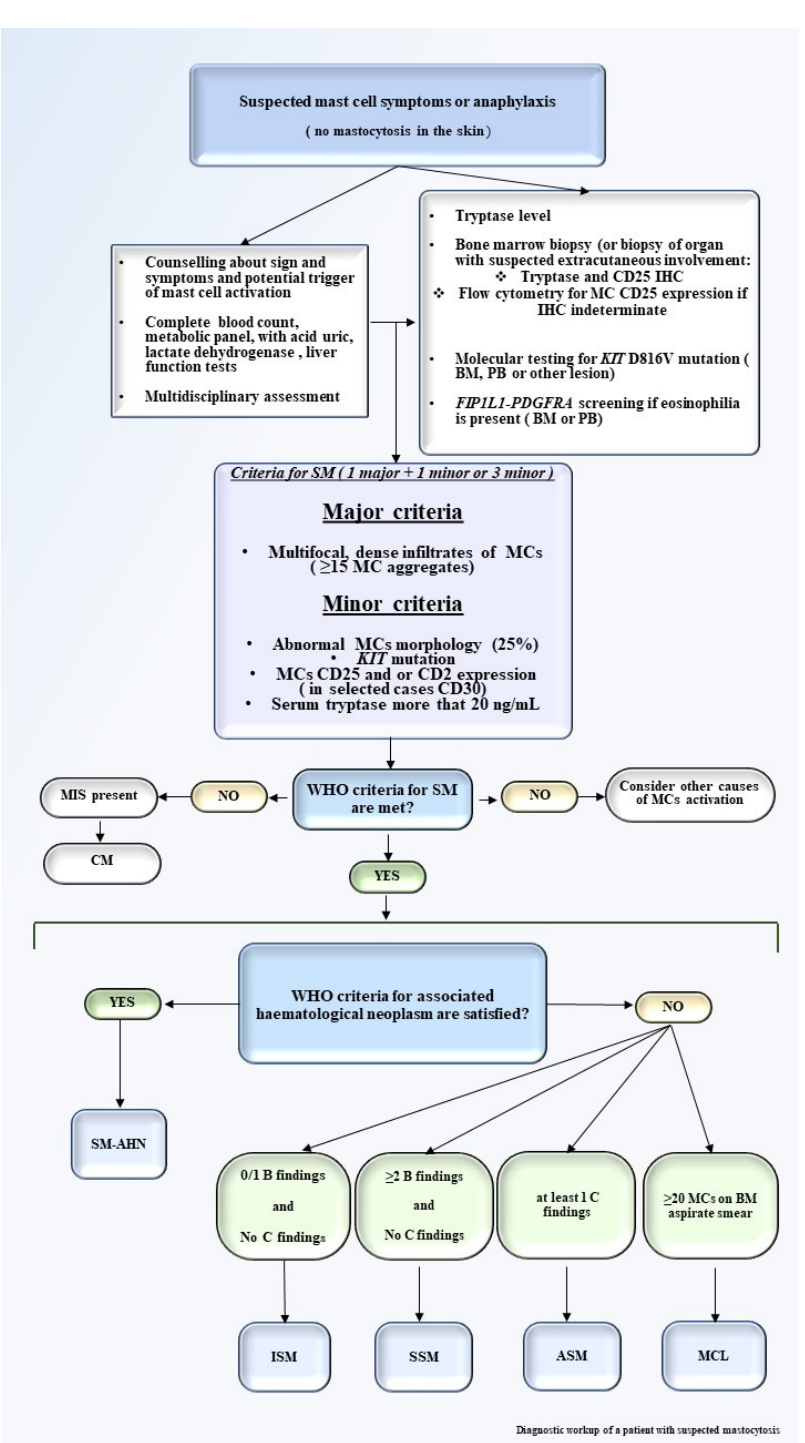
Figure 1. Diagnostic workup of a patient with suspected mastocytosis. The diagnostic workup of a patient with suspected mastocytosis should start with personal medication history, physical examination, counseling about triggers that may increase MCs activation, and collection of signs